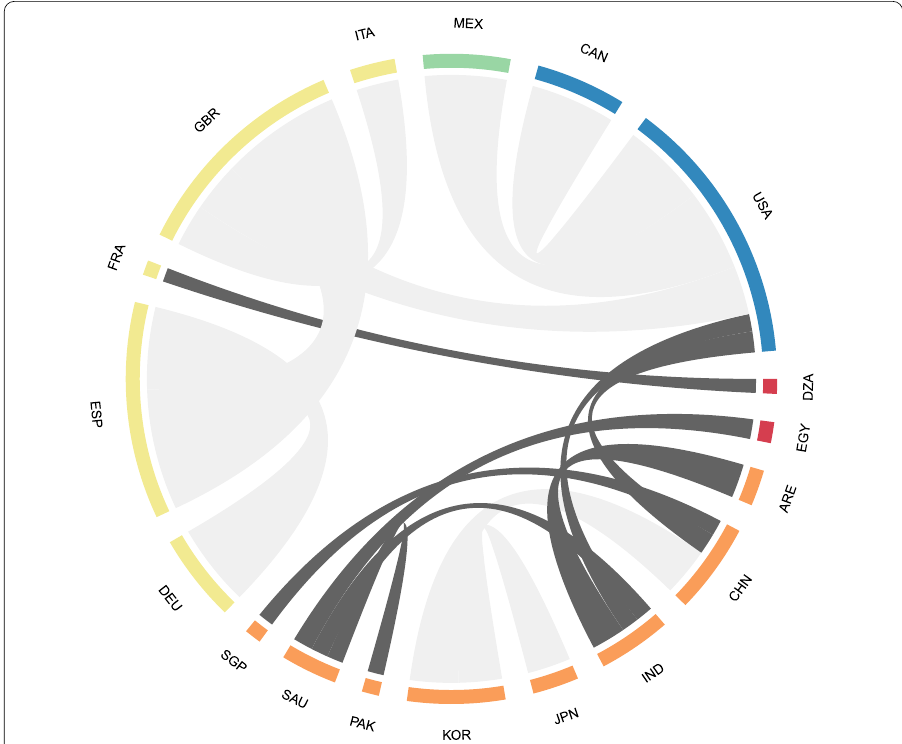
Figure 11 Categorisation of the ties between countries on the basis of the seasonal patterns (light grey: pattern I; dark grey: pattern II and III). The size of the ties is proportional to the annual average flow of passengers in the period 2010–2018 in both directions. For each seasonal pattern the top flows are shown ordered by world region. For a list of country-code abbreviations, please see the end of the article